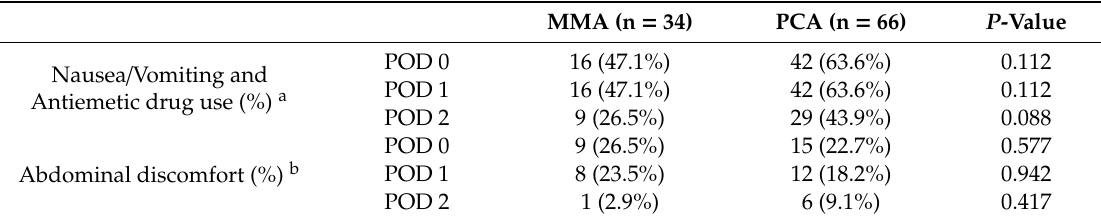
Table 4. Side e ff ects.